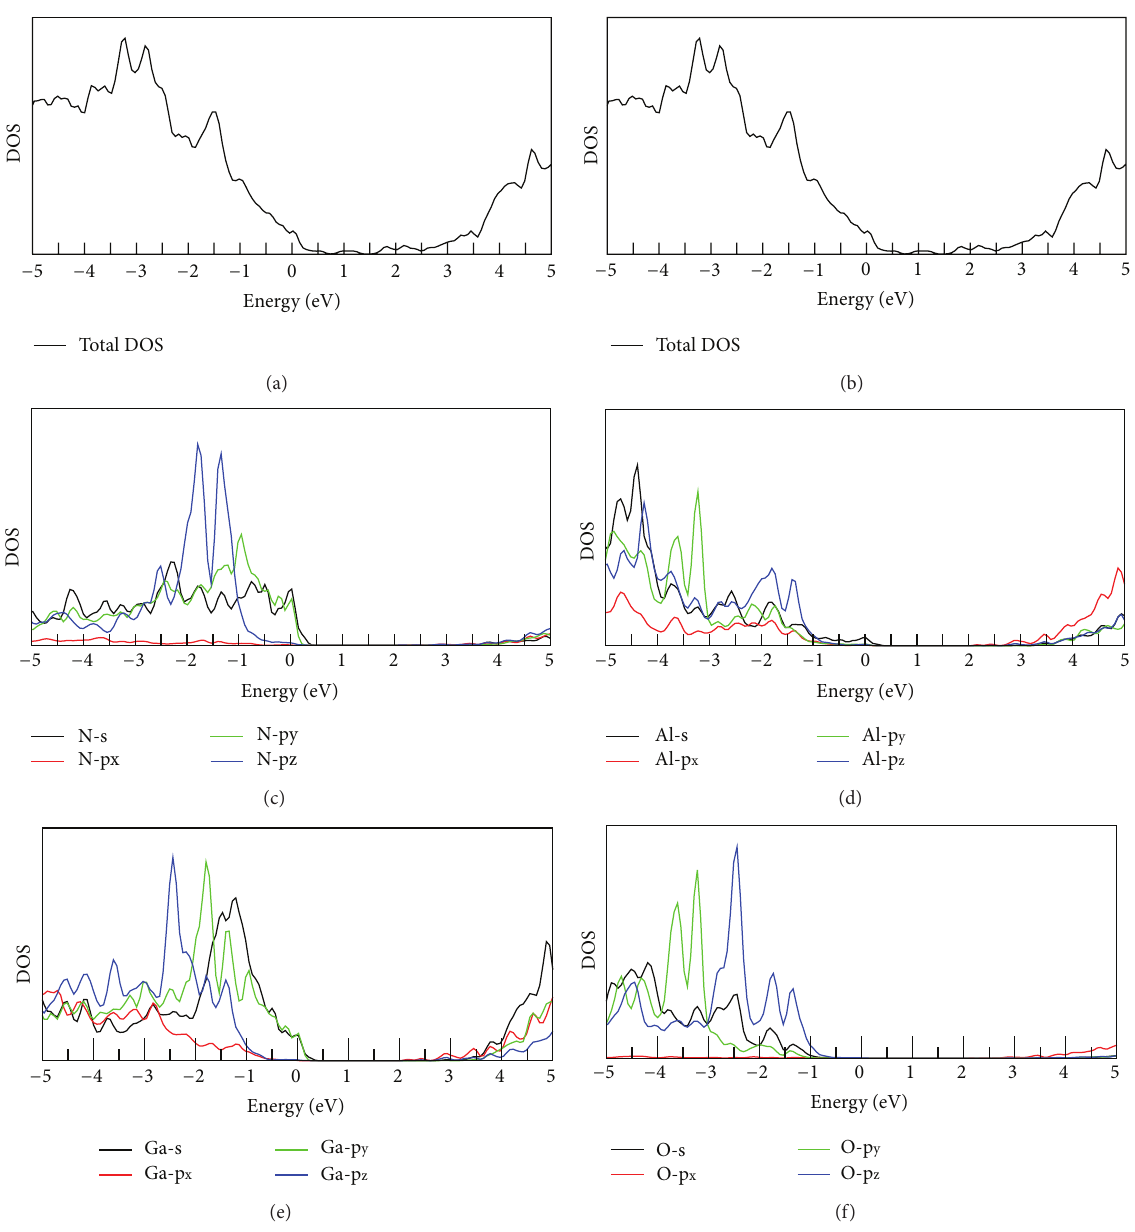
Figure 4: Projected density of states of N, Ga, Al, and O atoms located in the interface region. The Fermi level is located in zero.